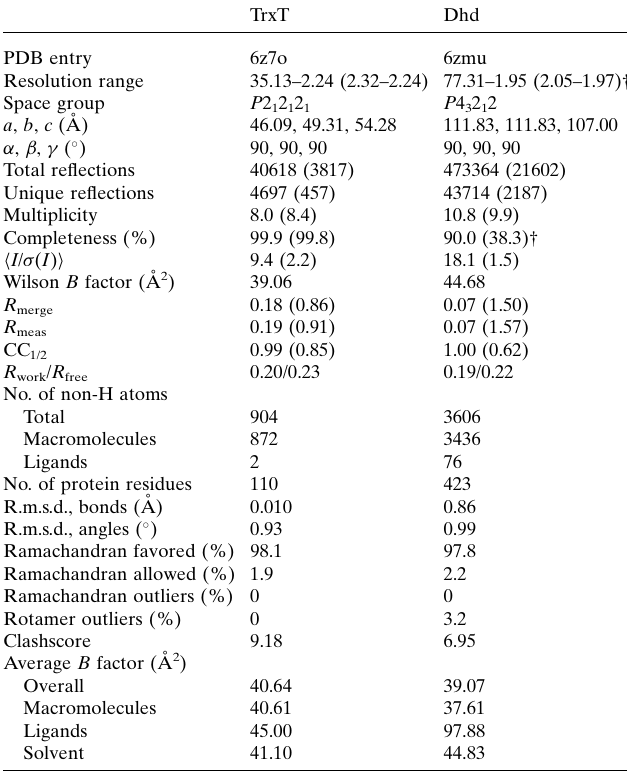
Table 1 Data-collection and refinement statistics. Values in parentheses are for the highest resolution